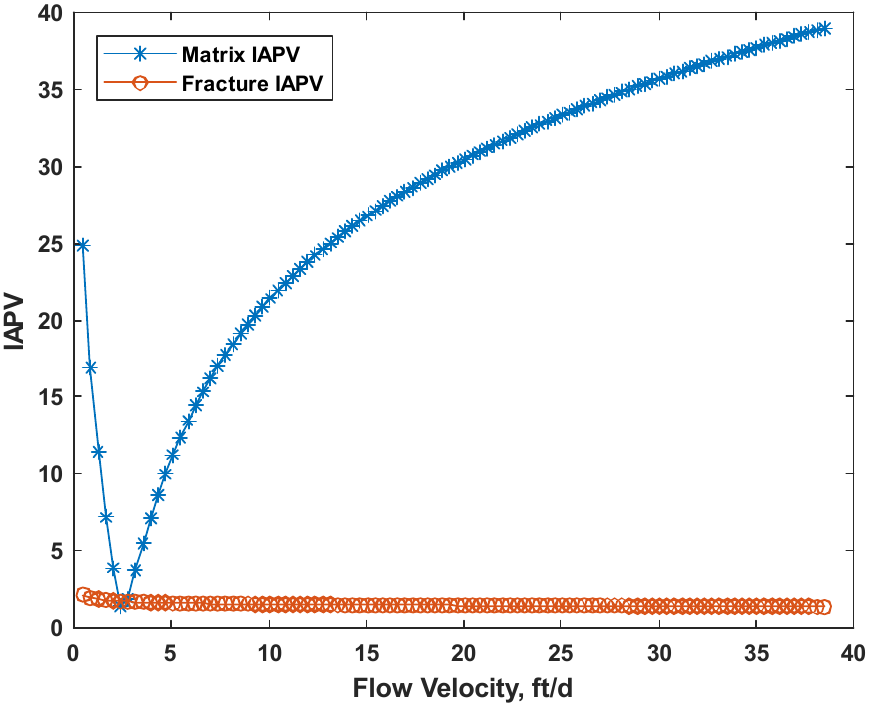
Figure 5. Effect of flow velocity on IAPV in percentage.